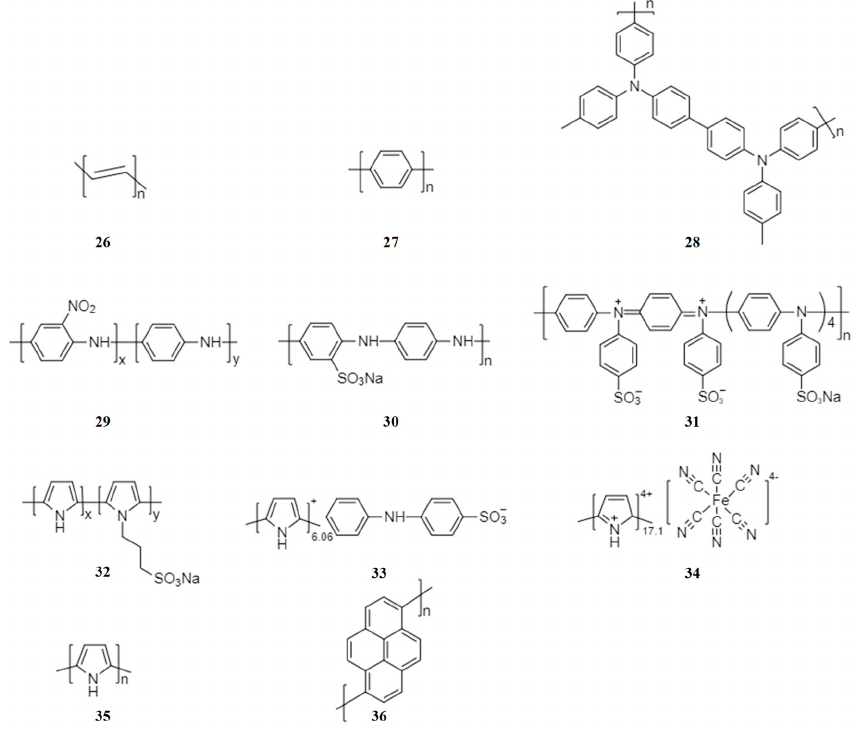
Figure 6. The structure of conjugated conductive polymers suitable for NIBs.